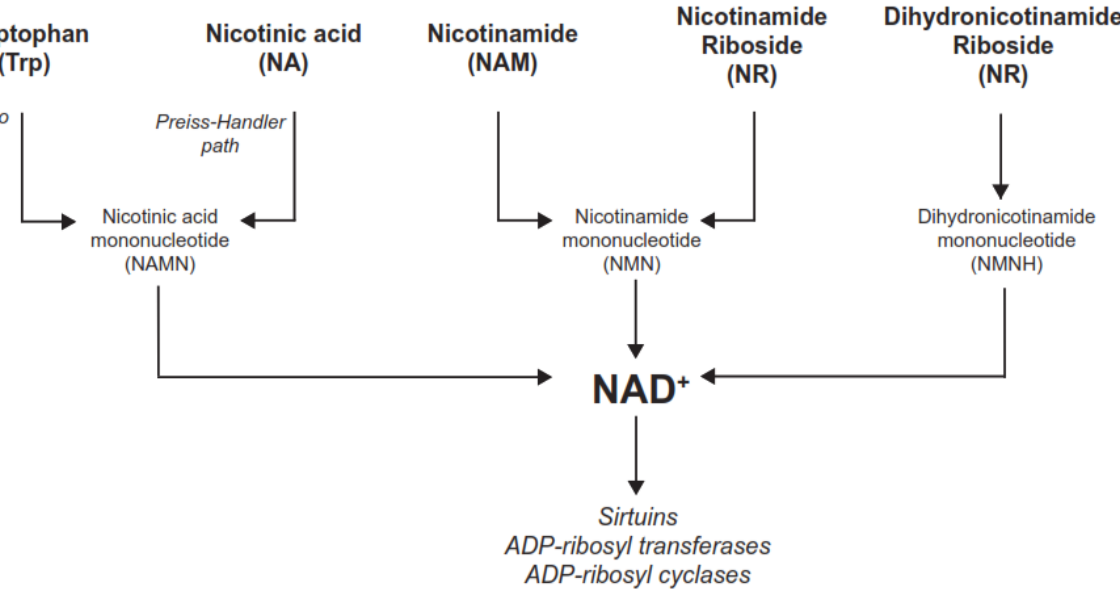
Figure 1. General scheme of NAD + synthesis and degradation: NAD + synthesis can be engaged from multiple precursors (in bold). Tryptophan (Trp) uses a path involving multiple reaction steps (de novo path). Nicotinic acid (NA), often referred to as niacin, also serves as an NAD + precursor. Trp and NA lead to the synthesis of a common intermediate mononucleotide molecule — the nicotinic acid mononucleotide (NAMN), which is further transformed into NAD + . Nicotinamide (NAM) can also be used to prime NAD + synthesis. Similarly, nicotinamide (NAM) and nicotinamide riboside (NR) can also be used as NAD + precursors, converging into the synthesis of nicotinamide mononu- cleotide (NMN), which is a common intermediate for NAD + synthesis. Finally, dihydronicotinamide riboside (NRH) is a recently discovered precursor using yet another independent path, leading to the generation of dihydronicotinamide mononucleotide (NMNH) and, ultimately, NAD + . In the fig- ure, NRH is depicted in its 1-4 form, but 1-2 and 1-6 forms might exist. NAD + can then be used by different families of enzymes, such as sirtuins, ADP-ribosyl transferases, or ADP-ribosyl cyclases.